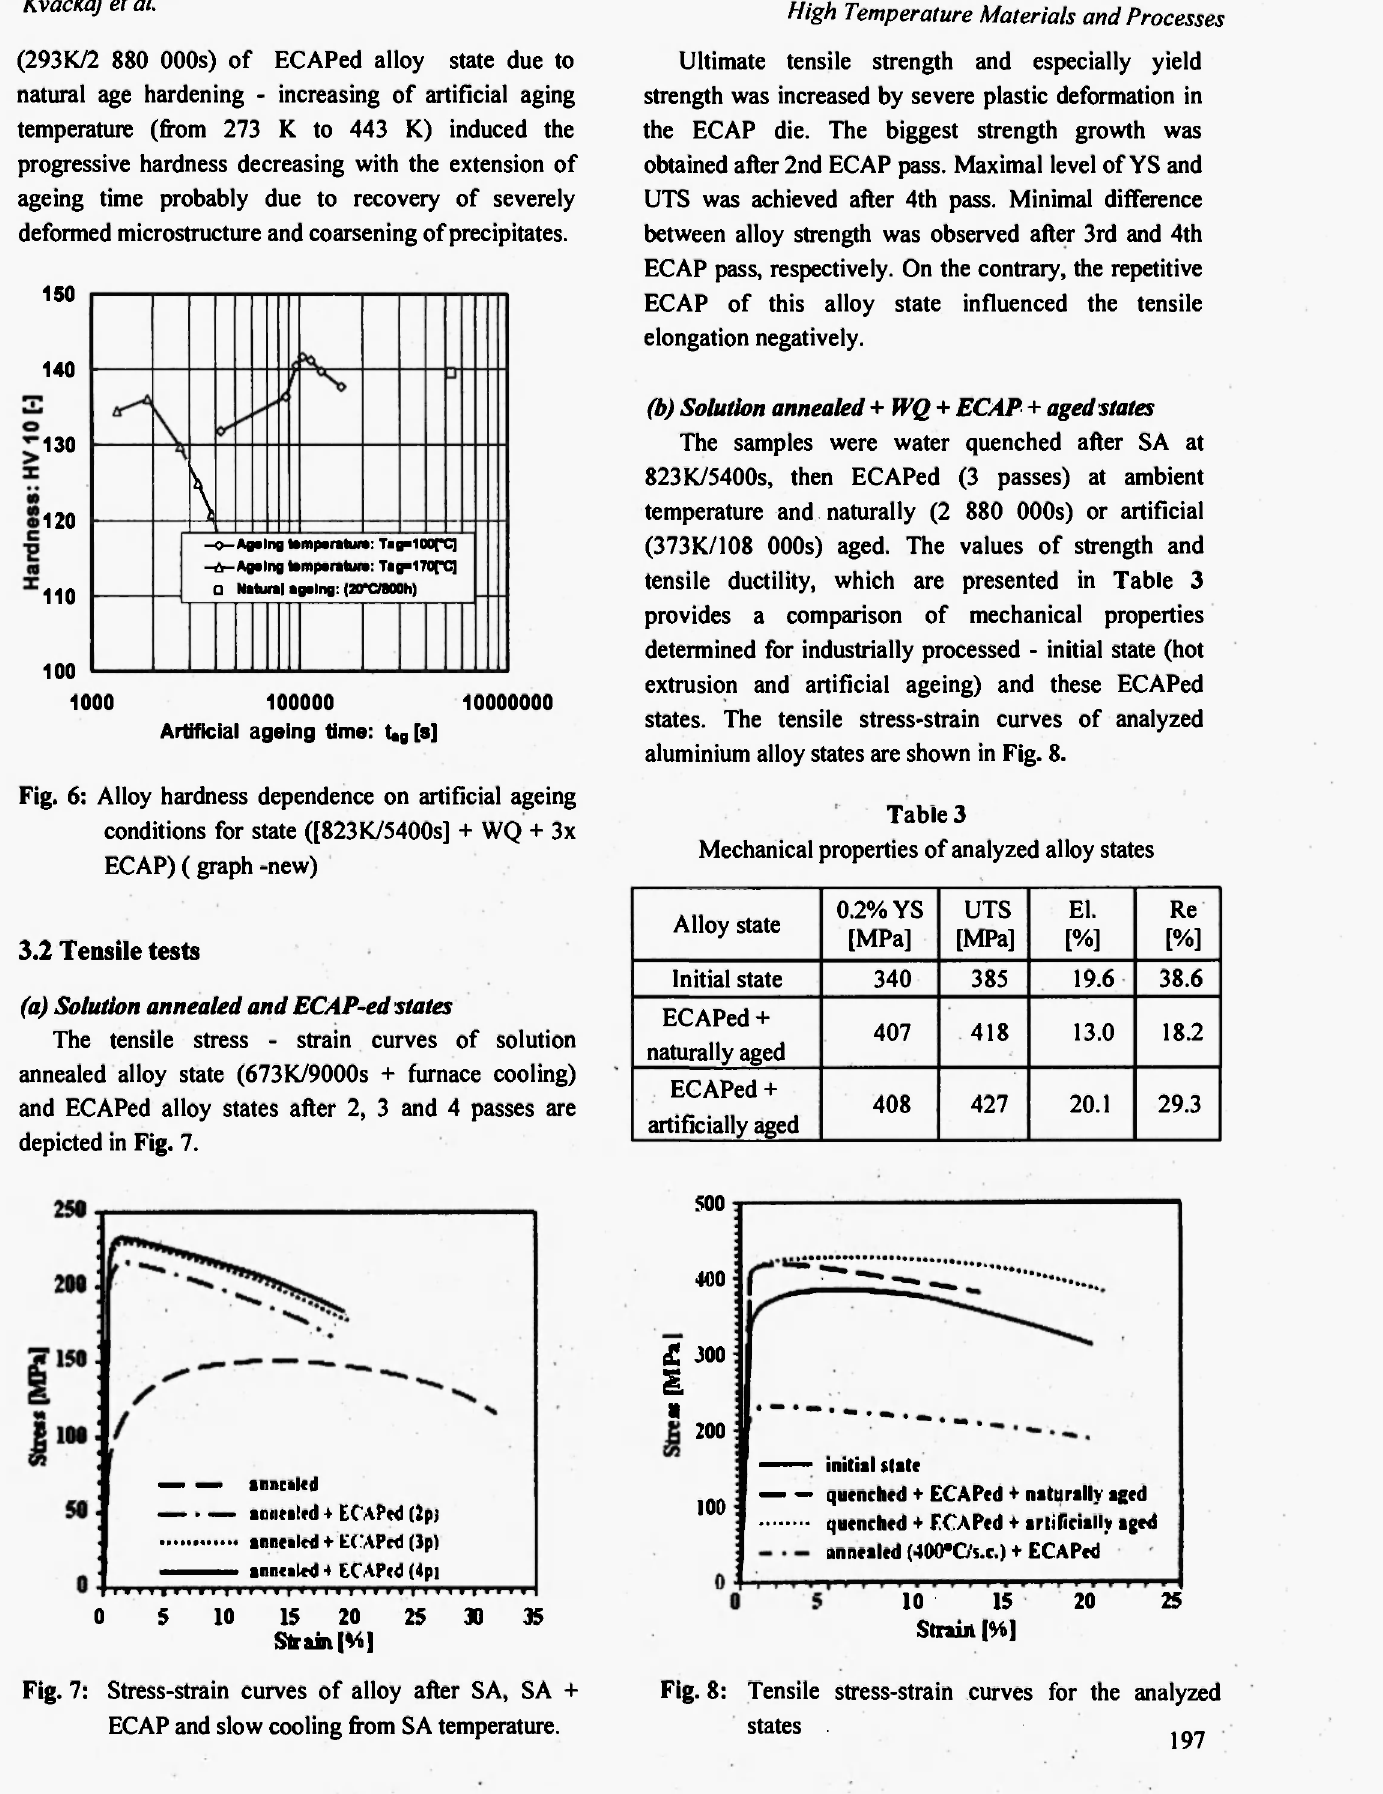
Fig. 8: Tensile stress-strain curves for the analyzed